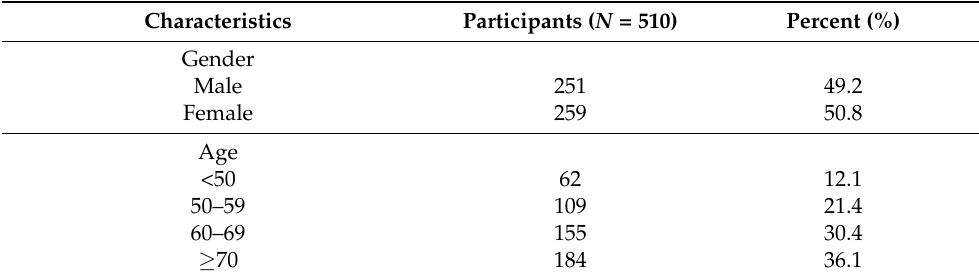
Table 1. Socio-demographic characteristics of the patients with diabetes or